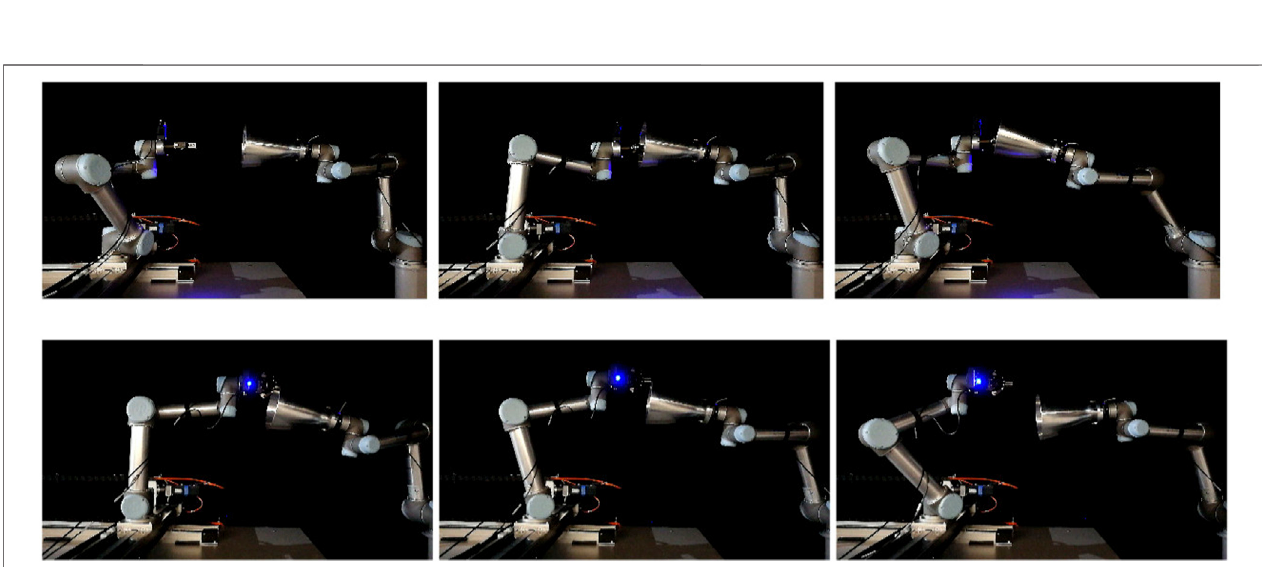
FIGURE15| Anexecutionsequenceforasuccessfulattemptforgraspno6 (toprow) andafailedattemptforgraspno7 (bottomrow) oftherealexperiment.The imagesshowtheapproachingpose (left) ,graspingpose (middle) ,and fi nalposeafterpulling (right) .Inthecaseofthesuccessfulattempt,therobotholdsthetargetfor the whole pull duration. In the failed attempt, after 3 s of pulling the gripper loses contact of the target and the grasp breaks.